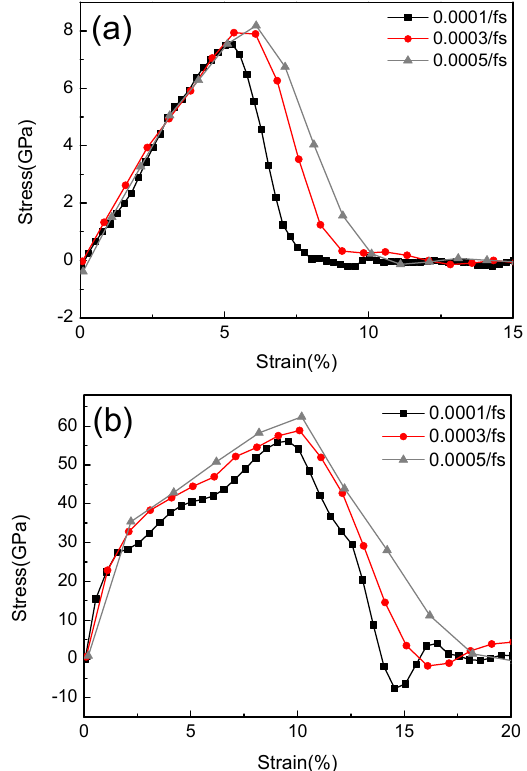
Figure 5. Stress–strain relationship at different strain rates. ( a ) Pristine CNCs. ( b ) CNCs-graphene layered composite.